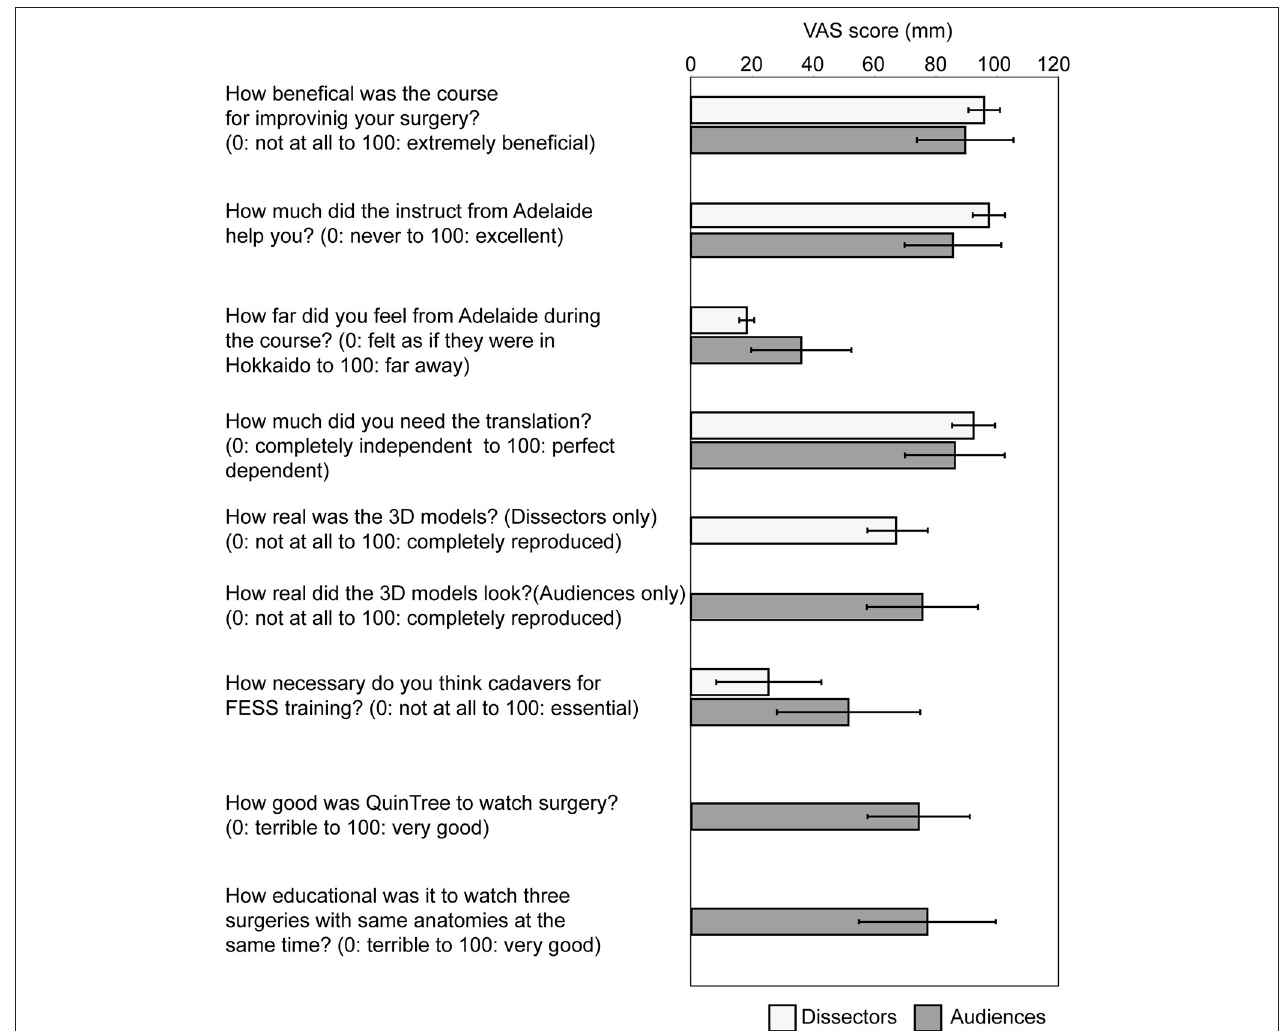
FIGURE 4 | The result of questionnaire from the dissectors and the audiences on educational benefits of the remote FESS training course. A questionnaire survey was performed on dissectors and audiences, including the following topic; the general benefit of the course to improve the surgical skills (0: not at all to 100: extremely beneficial), the usefulness of instructions from Adelaide (0: not at all to 100: excellent), subjective distance from Adelaide (0: felt as if they were in Hokkaido to 100: far away), the dependency on the translation between English and Japanese (0: completely independent to 100: perfect dependent), the reproducibility of the 3D sinus models to the real nasal cavity and paranasal sinuses (0: not at all to 100: completely reproduced, for dissectors only), the reproducibility of the 3D sinus models to the real nasal cavity and paranasal sinuses when watched on monitors (0: not at all to 100: completely reproduced, for audiences only), the necessity of using cadavers for the similar surgical training (0: not at all to 100: essential), the quality of the communication by Quintree (0: terrible to 100: very good), and the educational effect of watching the three surgeries with same anatomies at the same time by Quintree (0: terrible to 100: very good). Data were gathered by visual-analog scale and expressed as the mean ±